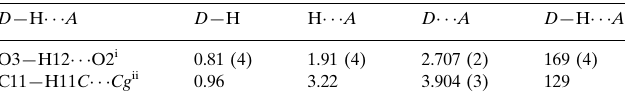
Hydrogen-bond geometry (A˚ , (cid:2)